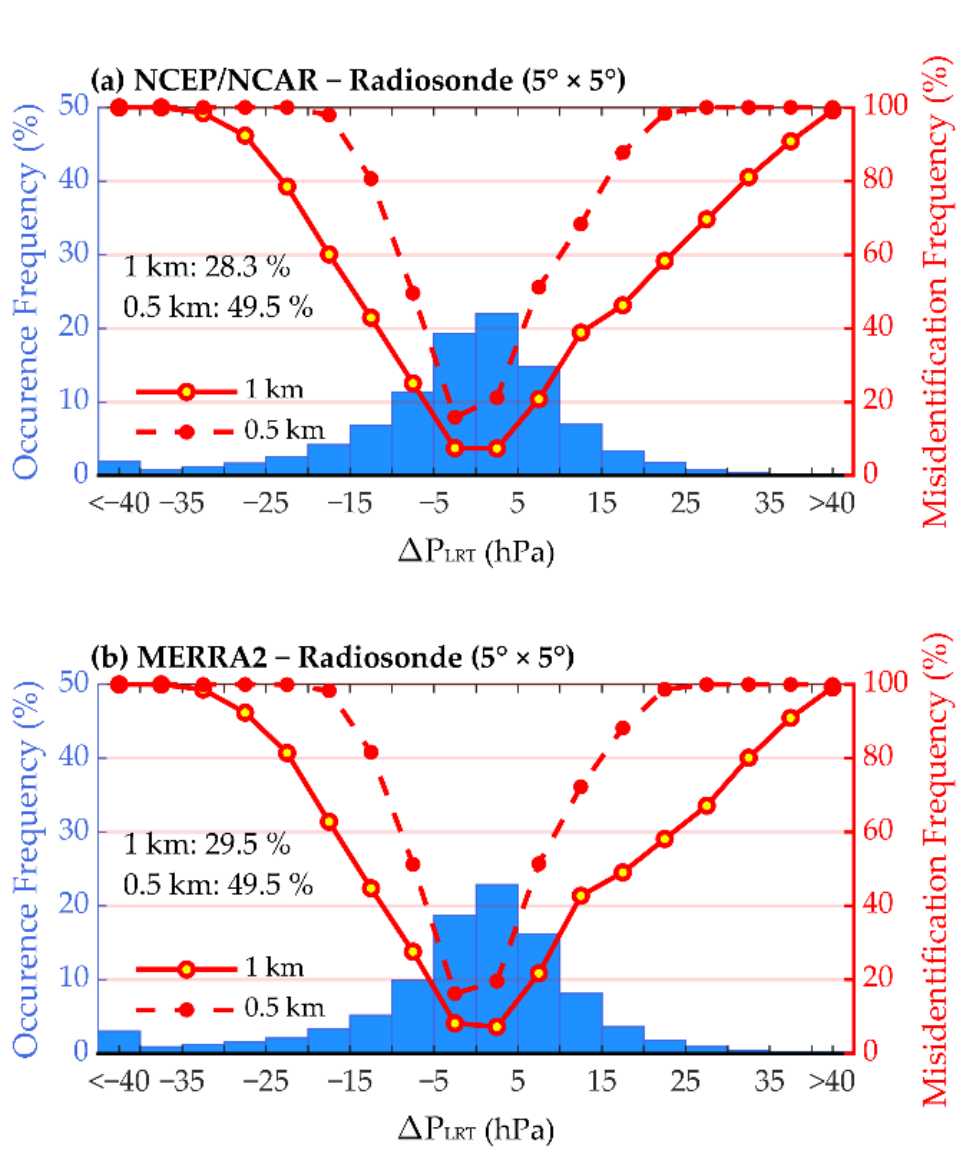
Figure 6. ( a ) Histogram of the P LRT biases in NCEP/NCAR (blue bar, left y -axis), based on all monthly samples at all available 5 ◦ × 5 ◦ regridded cells containing one or more radiosonde sites over 1980–2017. Ratio (right y -axis) of the number of samples with misidentified tropopause layer to the total number of samples in each of the bias intervals ( x -axis) at 1-km (red solid line) and 0.5-km (red dashed line) vertical resolutions. The text indicates the ratio of misidentified tropopause layers in NCEP/NCAR based on all monthly samples. ( b ) The same as ( a ), but for the P LRT biases in MERRA-2. The NCEP/NCAR and MERRA-2 data are remapped to a horizontal resolution of 5 ◦ × 5 ◦ in longitude and latitude to be consistent with TOST data.